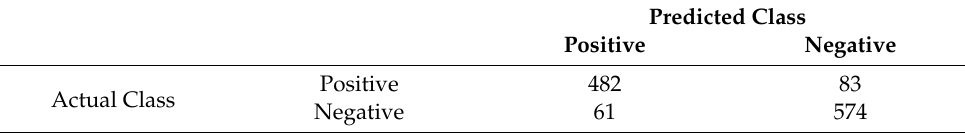
Figure 7. Example results with test images on which multiple complicated graffiti markings existed within the scene image. Table 1. Confusion matrix for calculating the accuracy of the trained R-CNN.